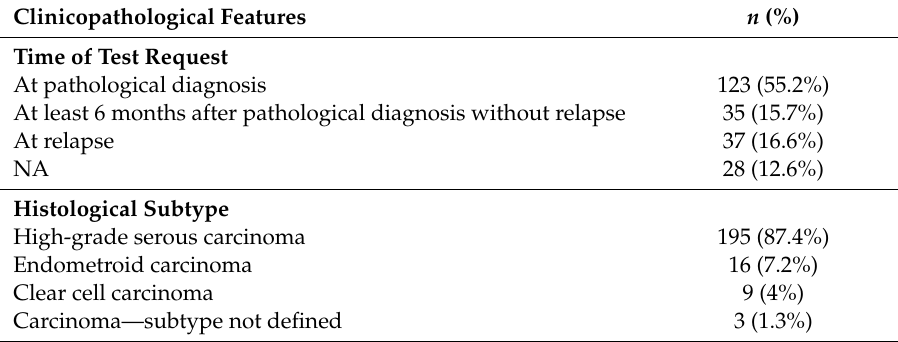
Table 4. Clinicopathological characteristics of the study